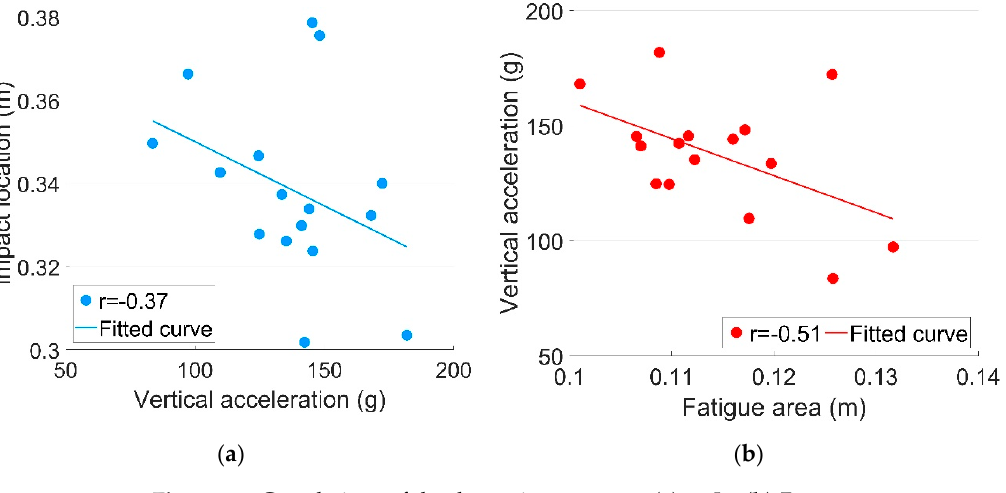
Figure 13. Correlations of the dynamic responses. ( a ) a y -L o ; ( b ) F a -a y .